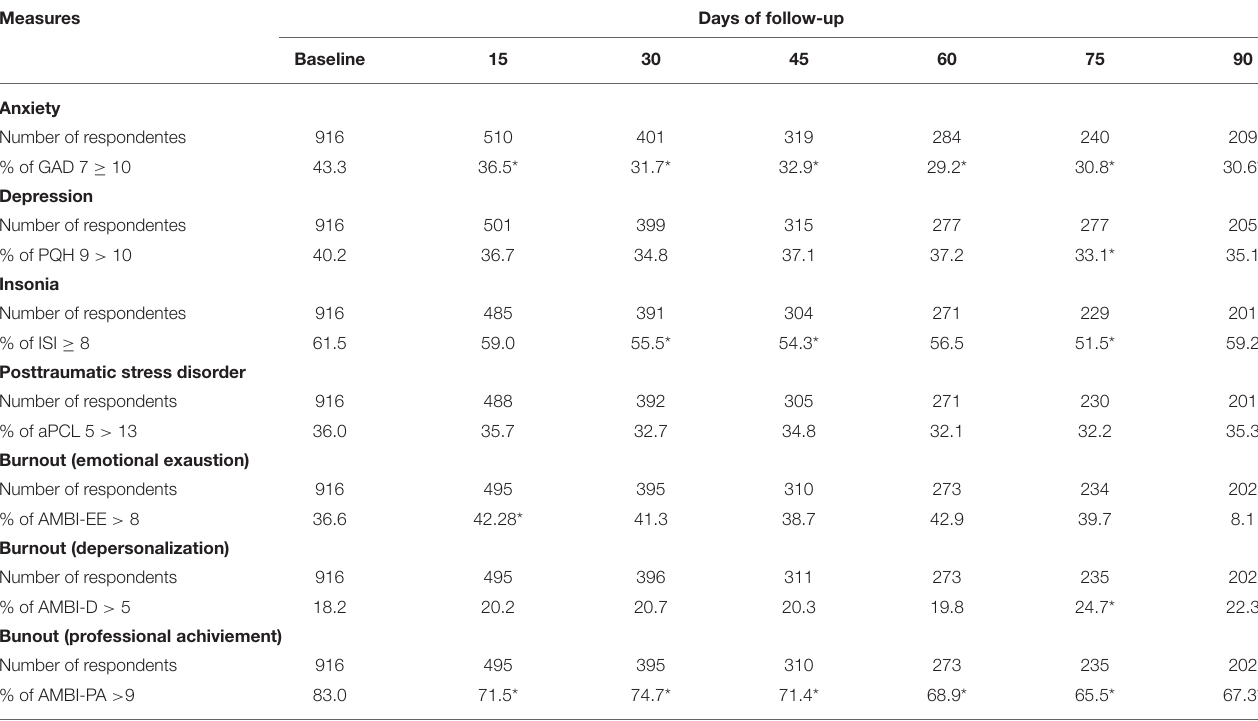
TABLE 2 | Follow-up of mental health indicators amog Brazilian health workers providing care to COVID-19